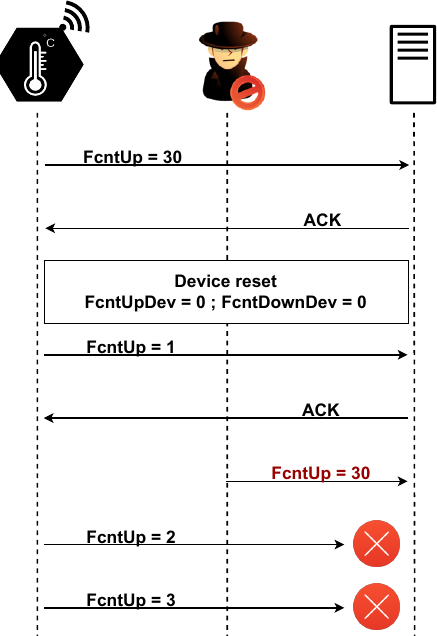
Figure 9. ABP device exploiting the Replay Attack. Adapted from